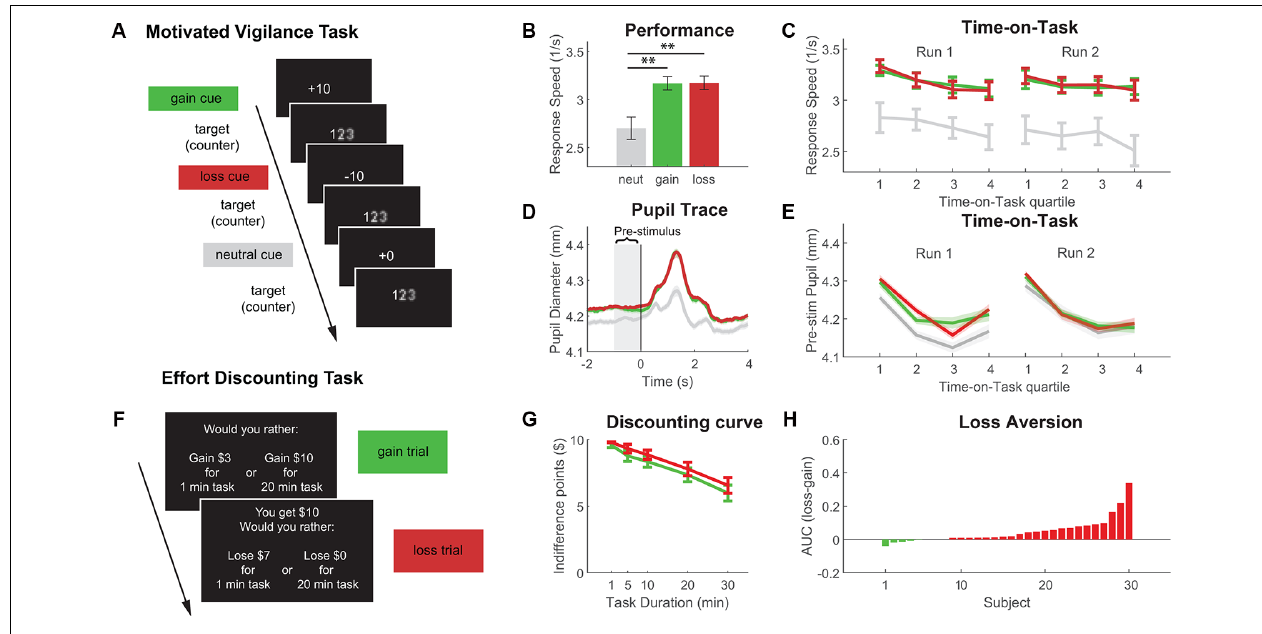
FIGURE 2 | Results from Experiment 2 with (A) schematic of the Motivated Vigilance Task, (B) response speed in the vigilance task for baseline, gain and loss conditions, (C) Time-on-Task decline of response speed (Time-on-Task quartiles for illustrative purposes, statistical analysis was based on linear slopes), (D) target-locked pupil trace in the vigilance task (time = 0 indicates target presentation), (E) Time-on-Task decline of pre-stimulus pupil diameter (Time-on-Task quartiles for illustrative purposes only, statistical analysis was based on linear slopes), (F) example trials of the effort-discounting task, (G) effort-discounting curve, and (H) loss-gain difference in the area under the discounting curve (AUC; positive difference scores denote less discounting for loss vs. gain choices). ∗∗ p <